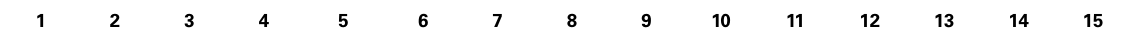
AQ, autism spectrum quotient; SPQ, schizotypal personality questionnaire; M, mean; SD, standard deviation.